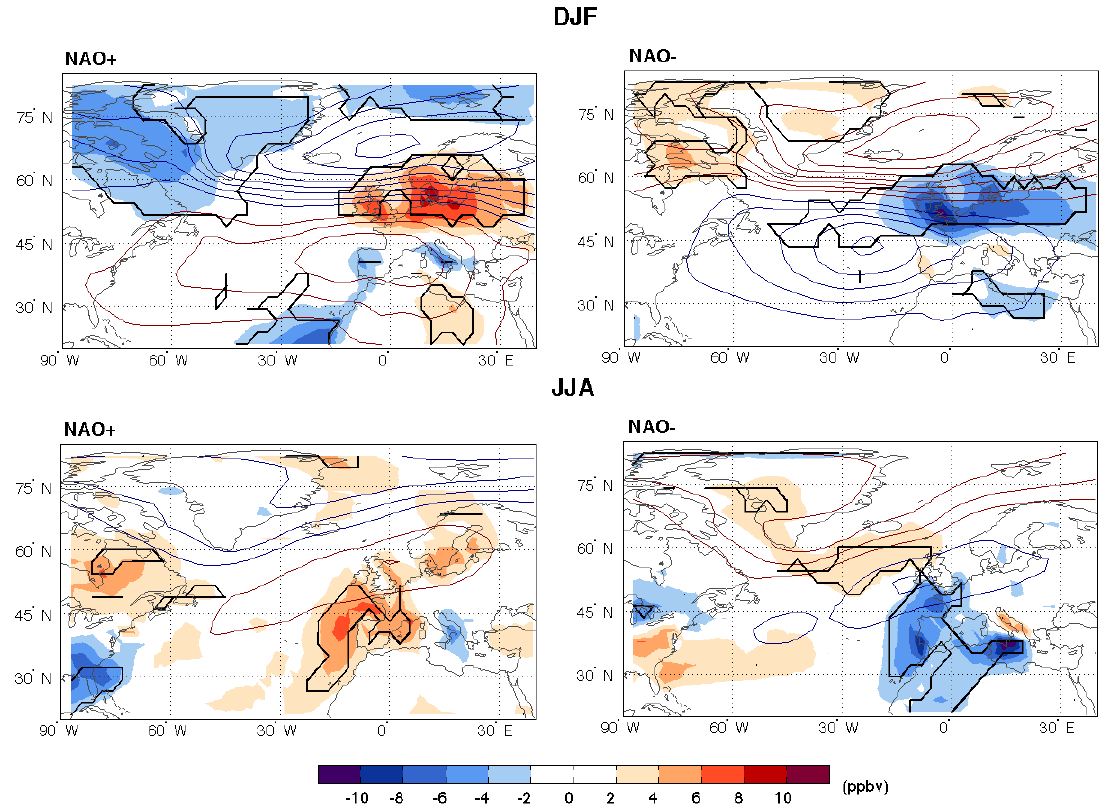
Fig. 6. Positive (red contours) and negative (blue contours) SLP and surface O 3 mixing ratio (color shading) anomalies associated with the ensemble average of positive (right) and negative (left) NAO phase for winter (top) and summer (bottom) months. Contours have 1.5hPa interval. The bold black contours indicates O 3 anomalies significant with 90%